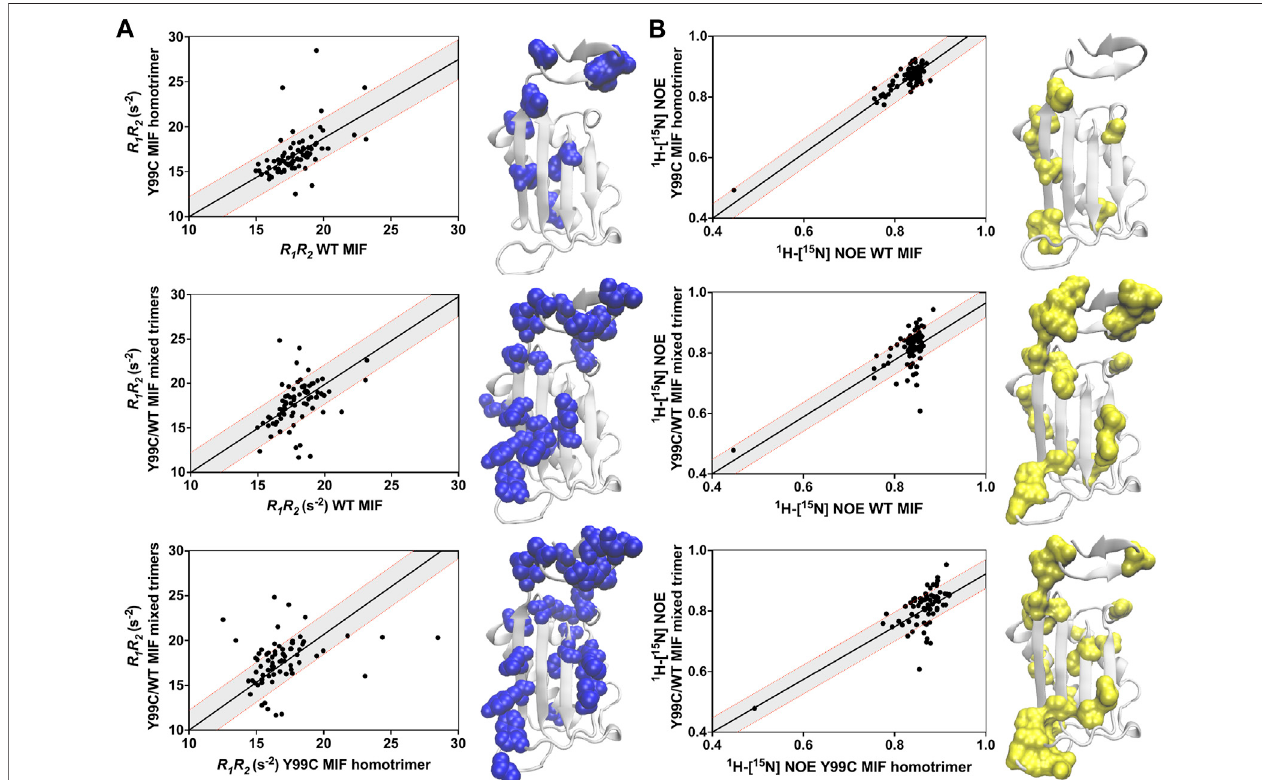
FIGURE 5 | Correlation plots of the (A) R 1 R 2 and (B) 1 H-[ 15 N] NOE relaxation rates for the Y99C variants relative to WT MIF and each other. Gray shaded areas denote ±1.5 σ from the linear least-squares fi ts of the data (black lines). Residues outside of the 1.5 σ correlation boundaries are mapped onto the MIF monomer (PDB: